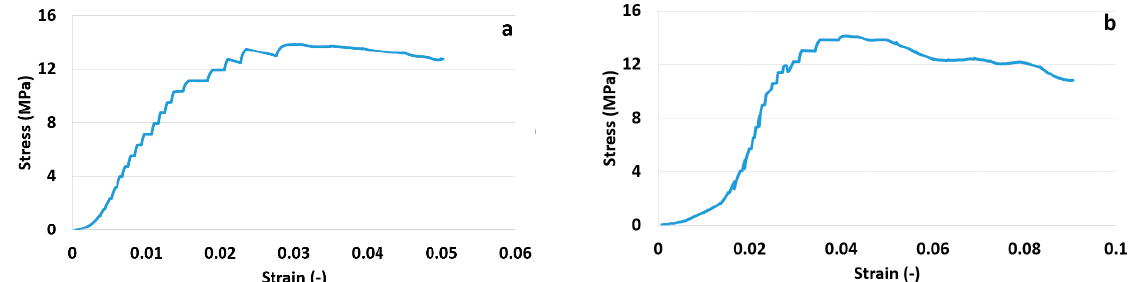
Figure 6. Stress vs strain for Sample 1 ( a ) and Sample 2 ( b ).